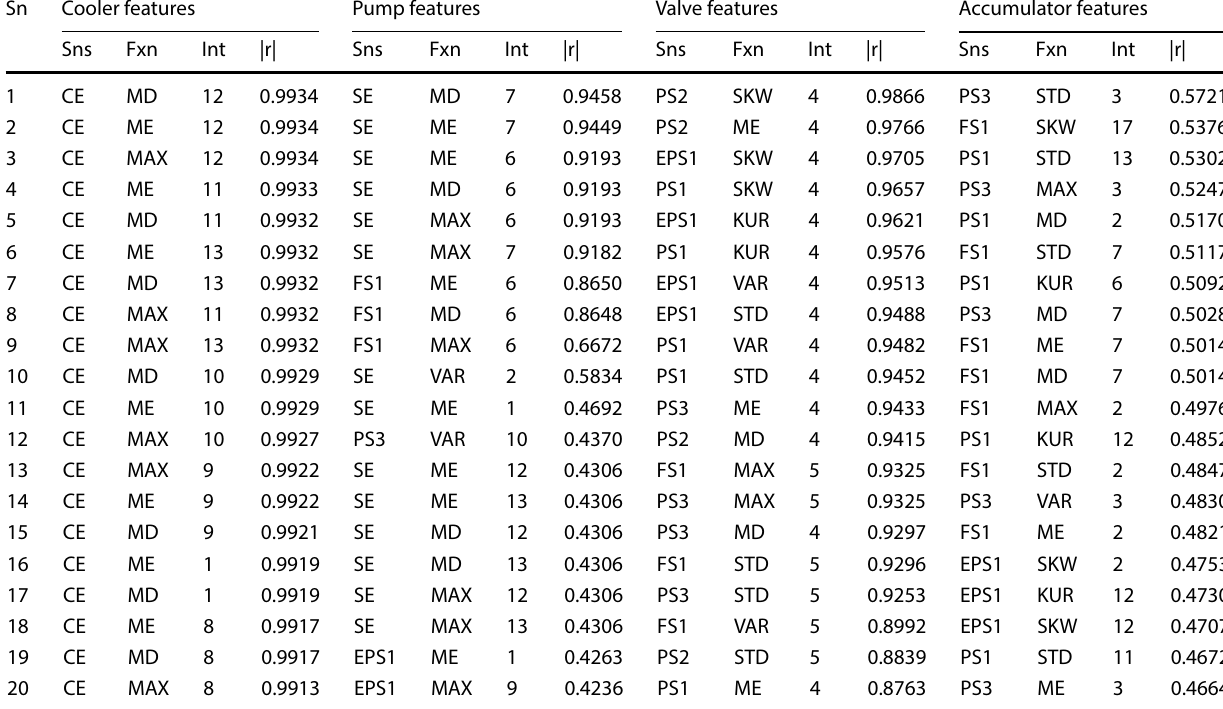
Table 2 Highly correlated features selected for specific fault